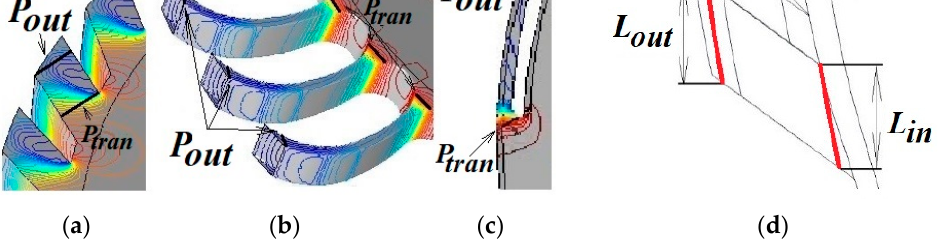
Figure 3. The solid-state model for the straight ( a ), profiled ( b ) and annular channels ( c ), pressure and velocity reading lines during simulation ( d ).